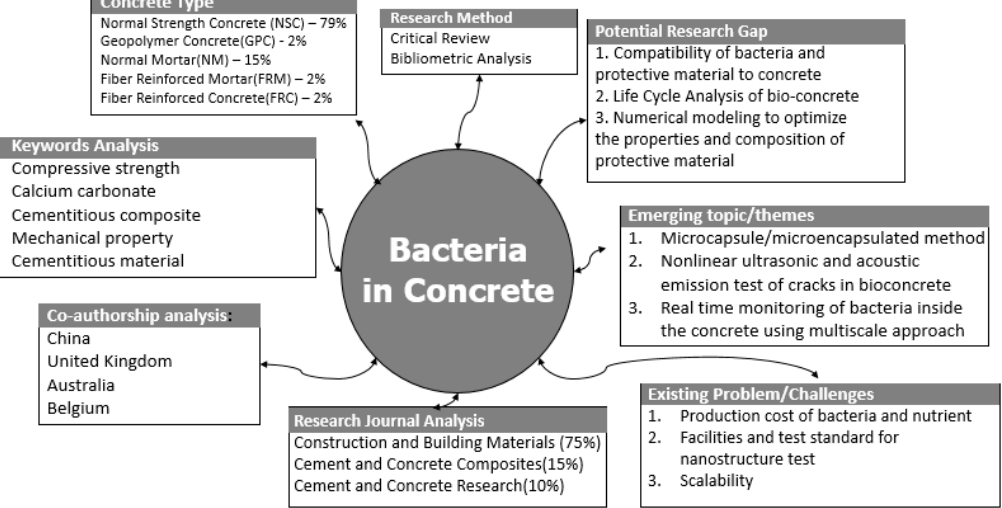
Figure 6. Summary of Findings in Bacterial Concrete.